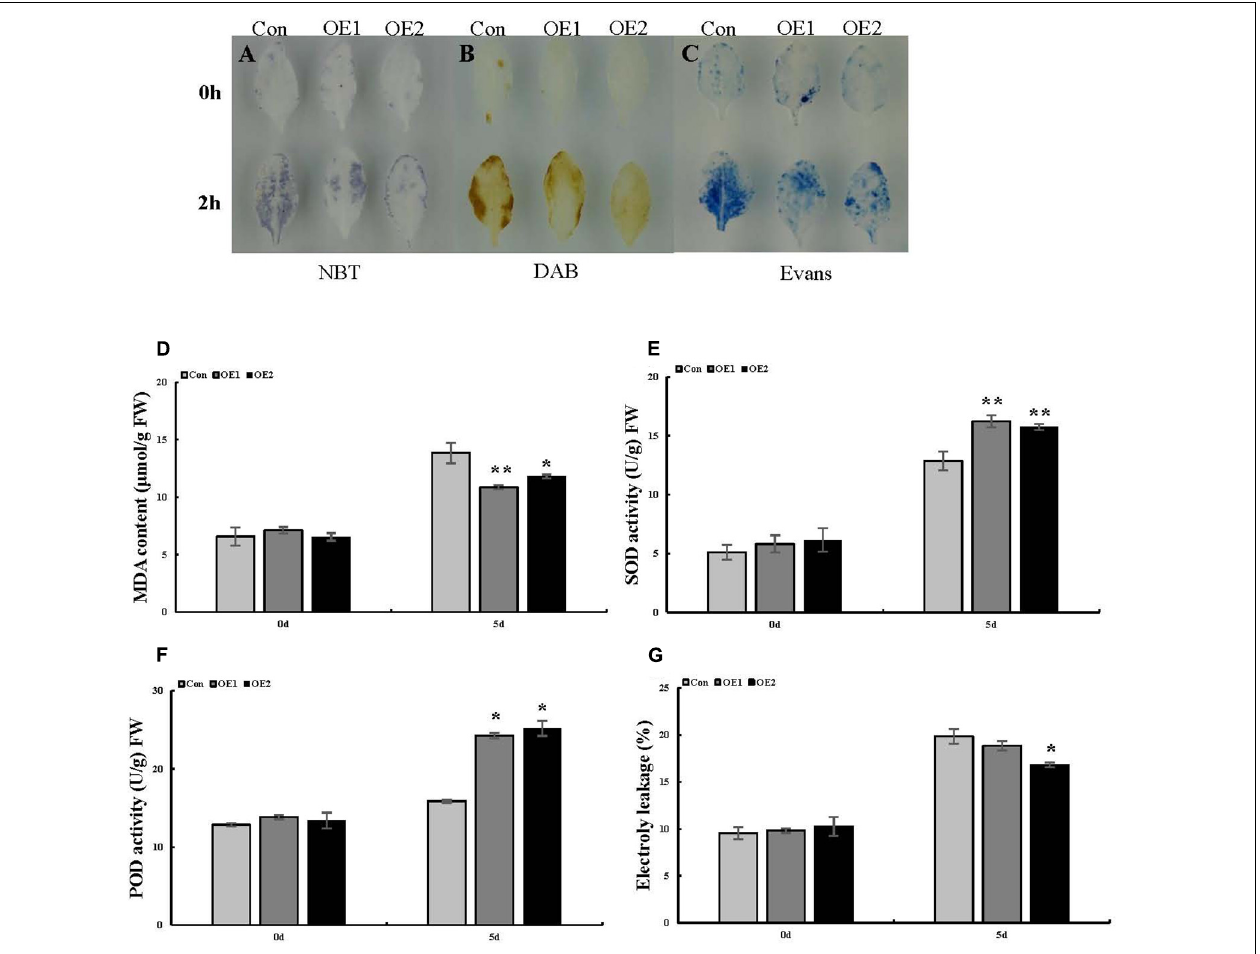
FIGURE 5 | Analysis of ROS-scavenging capability and cell death in Arabidopsis plants overexpressing ThSOS3 . (A) NBT, (B) DAB, and (C) Evans blue staining were performed. Leaves from ThSOS3 -transformed and Con (WT Arabidopsis) plants treated with 150 mM NaCl for 24 h were used for histochemical staining. (D–F) Analysis of MDA content, SOD and POD activity, and electrolyte leakage in transgenic and Con (WT Arabidopsis) plants. Four-week-old Arabidopsis seedlings subjected to 150 mM NaCl for 24 h were used to detect the MDA (D) content, SOD (E) and POD (F) activity, and electrolyte leakage (G) . *Represents a significant difference ( P < 0.05). **Represents a very significant difference ( P <